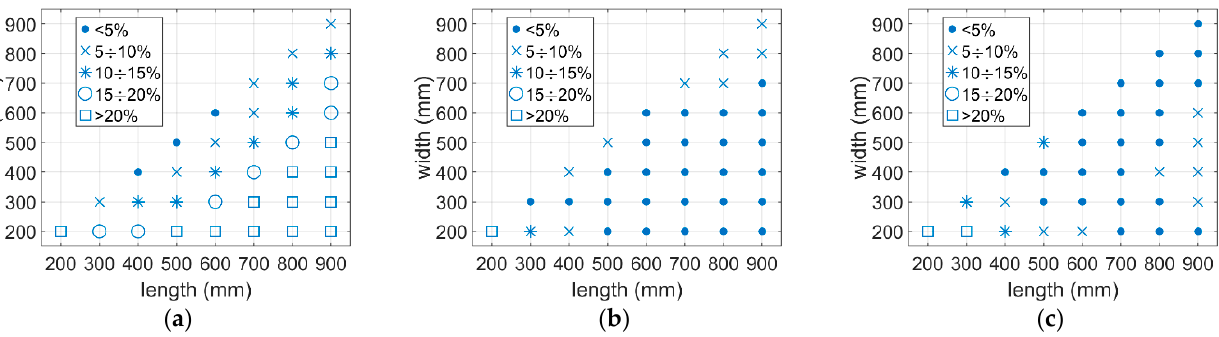
Figure 15. The prediction error distribution obtained using the analytical model for the second extreme: ( a ) H = 200 mm; ( b ) H = 500 mm; ( c ) H = 800 mm.